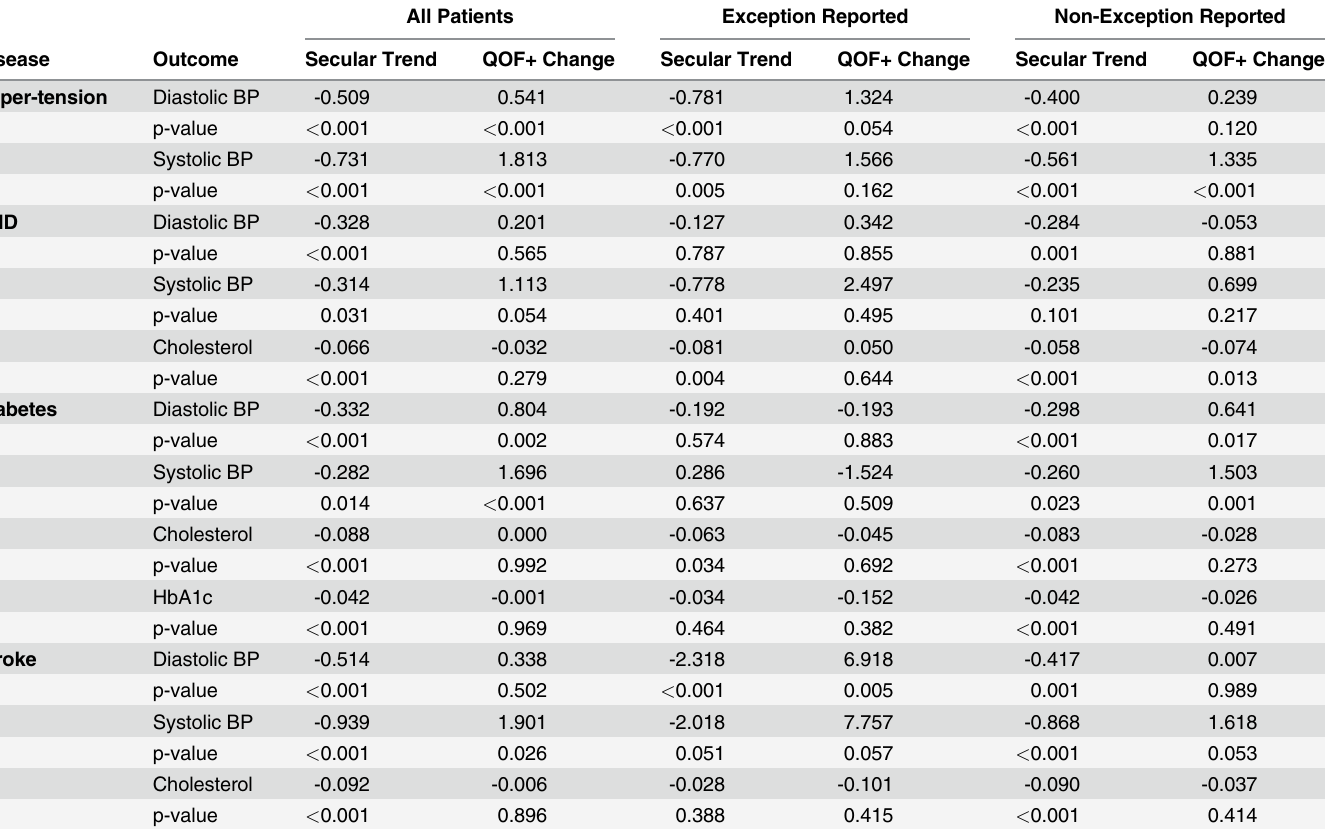
Table 5. Change in the bio-parameter for the indicator shown in the row for the group of patients mentioned in the column (all patients, exception reported patients, non-exception reported